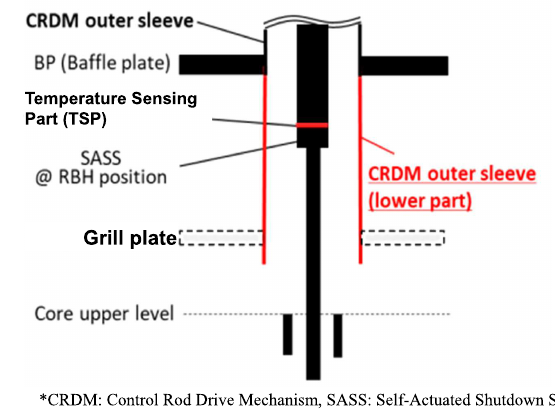
Fig. 4. Analysis model for CFD code.